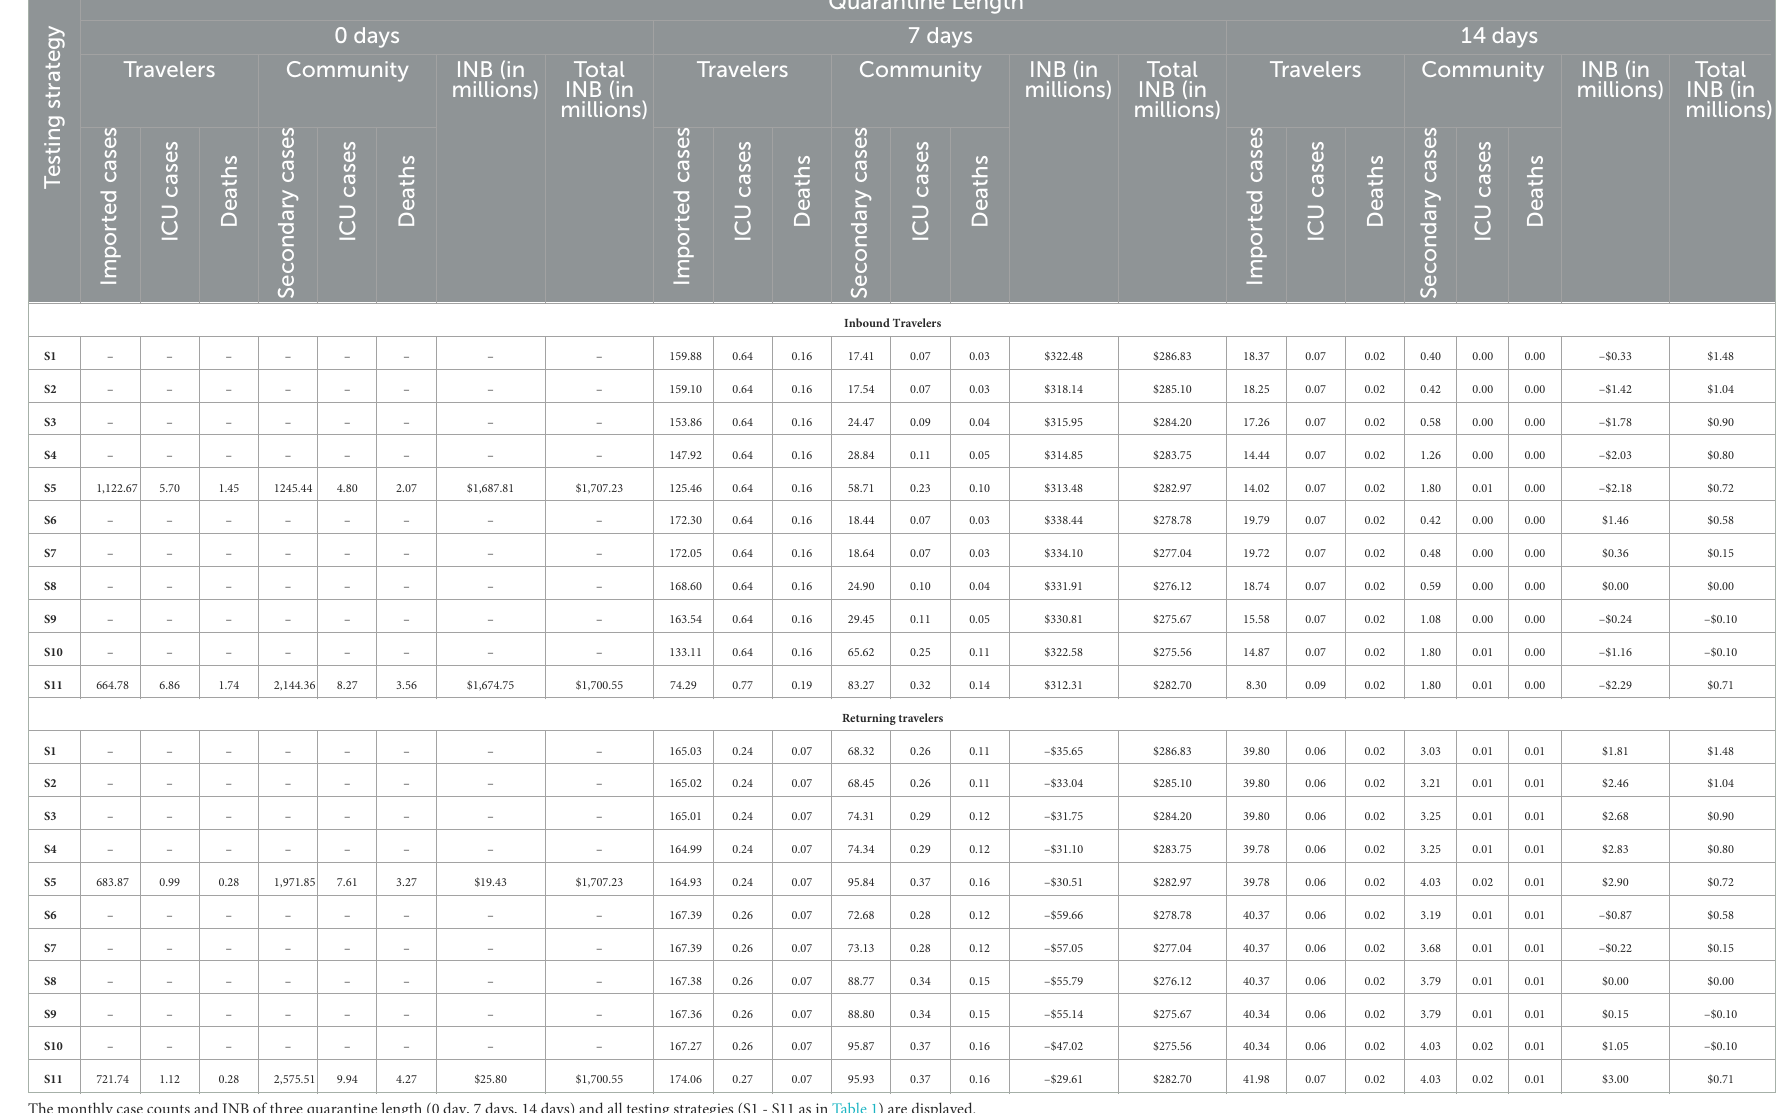
TABLE 2 Monthly COVID-19 case counts and INB from vaccinated travelers under different